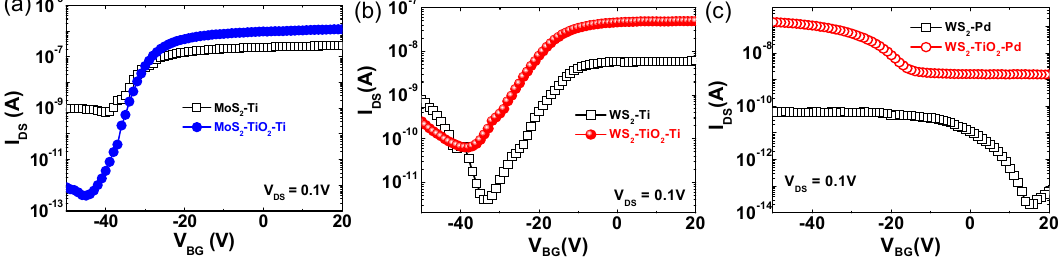
Figure 2. Transfer curves (I DS -V BG ) for ( a ) MoS 2 -Ti and MoS 2 -TiO 2 -Ti, ( b ) WS 2 -Ti and WS 2 -TiO 2 -Ti, ( c ) and WS 2 -Pd and WS 2 -TiO 2 -Pd.